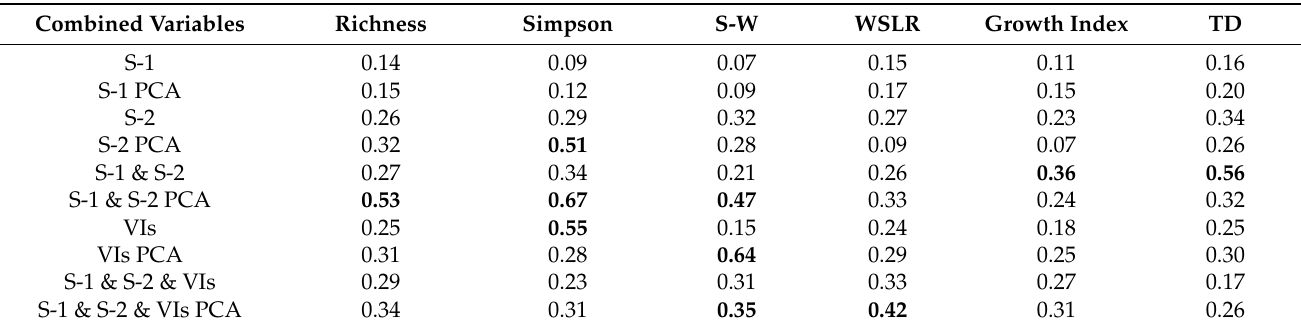
Table 3. Estimated prediction accuracy ( “ r 2 ) for the six diversity indices. Estimated accuracy ( “ r 2 ) in bold correspond to an “ r 2 > 0.35.